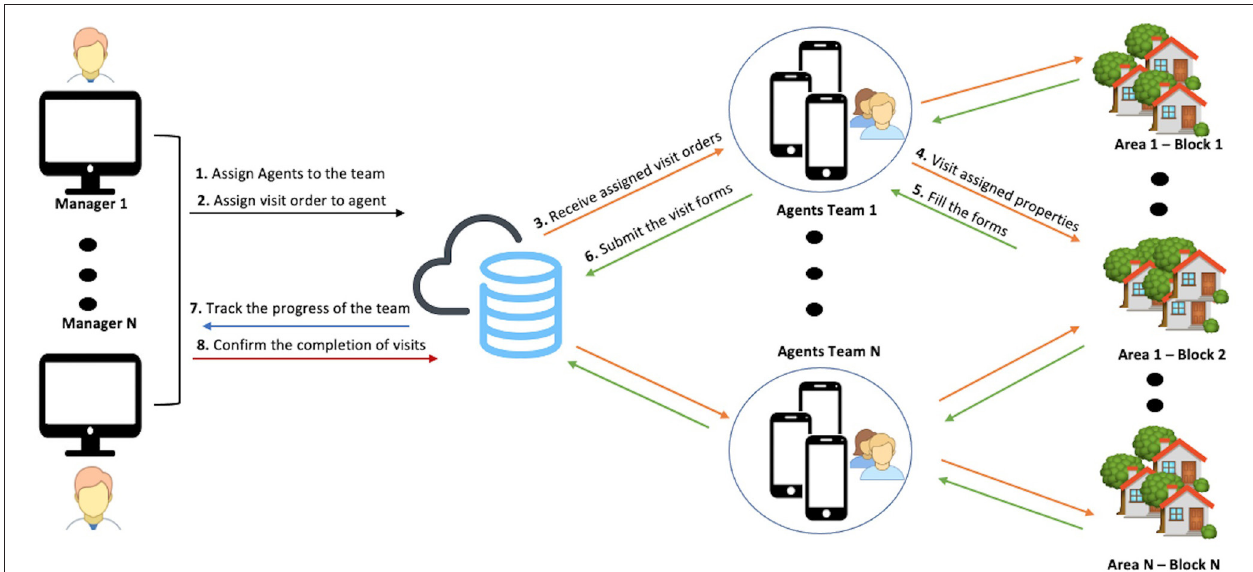
FIGURE 4 | Overview of the proposed MEWAR